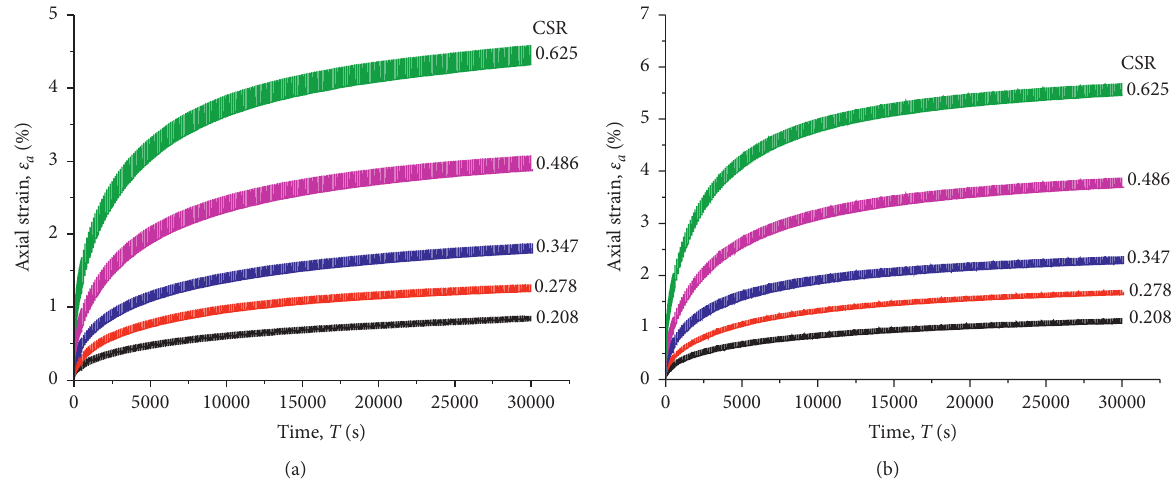
Figure 6: Typical time-history curves of axial strains: (a) η ampl � 1; (b) η ampl � 0.5.